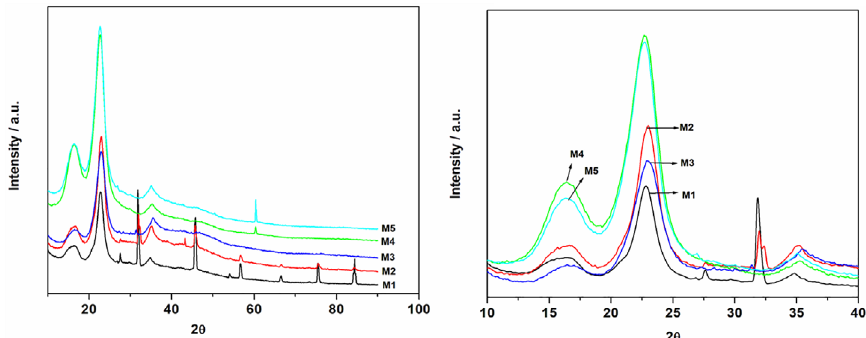
Figure 7. XRD diffractograms of the five methods used for the extraction of cellulose from sugarcane Bagasse